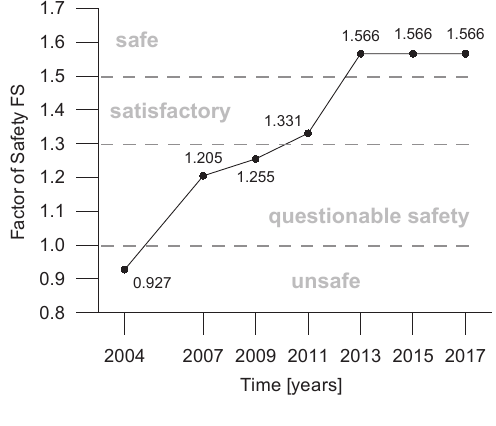
Fig. 9. Stability analysis results (Bishop’s method) Figure 9 : Stability analysis results (Bishop’s